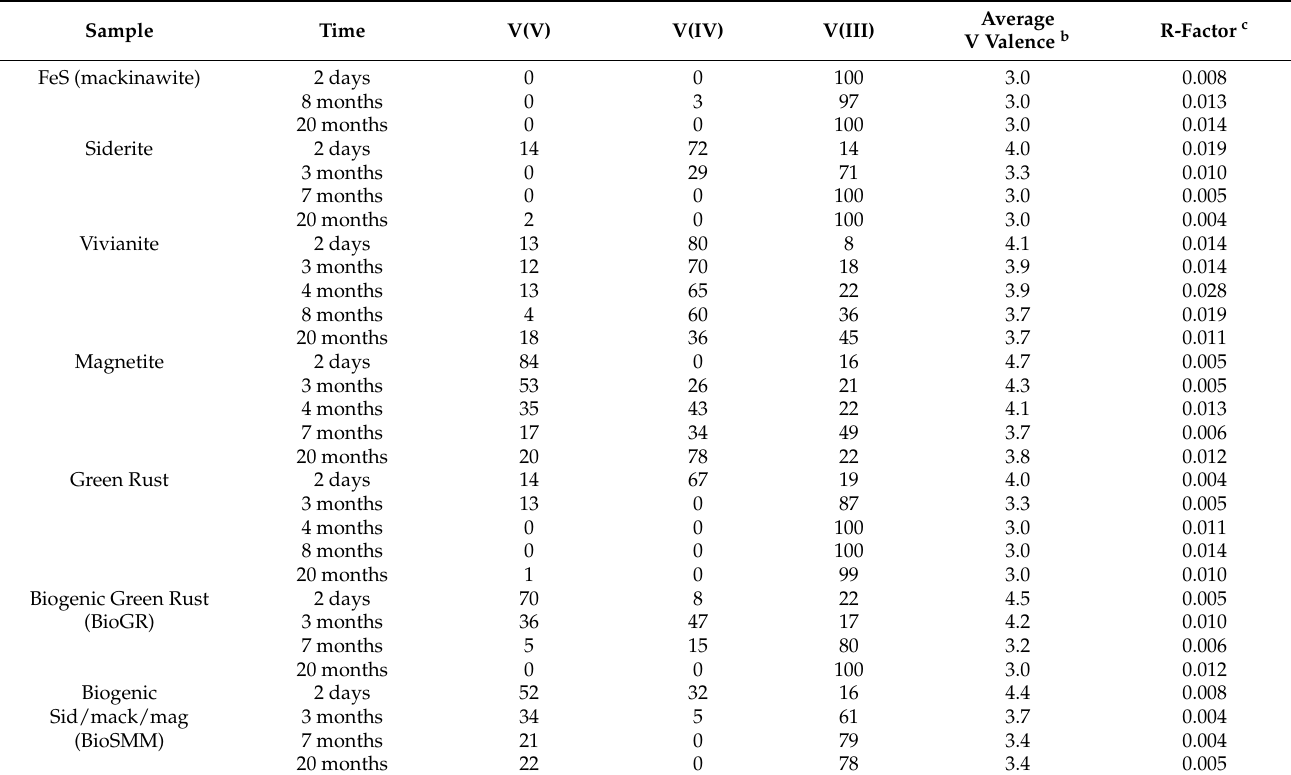
Table 1. Refined spectral components (%) from the linear combination analysis of the XANES data a .